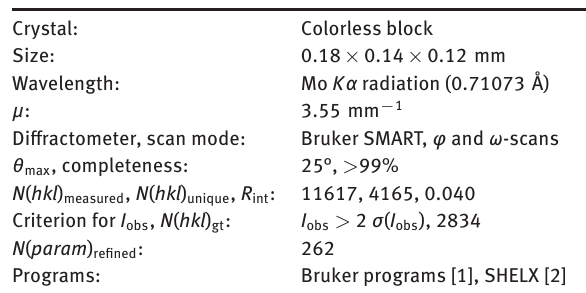
Table 1: Data collection and handling.